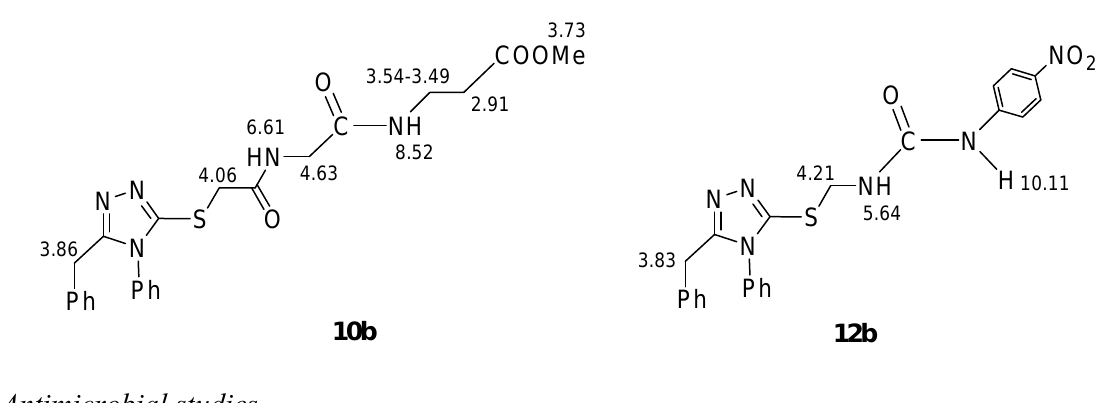
Figure 2. Selected 1 H-NMR assignments of compounds 10b and 12b